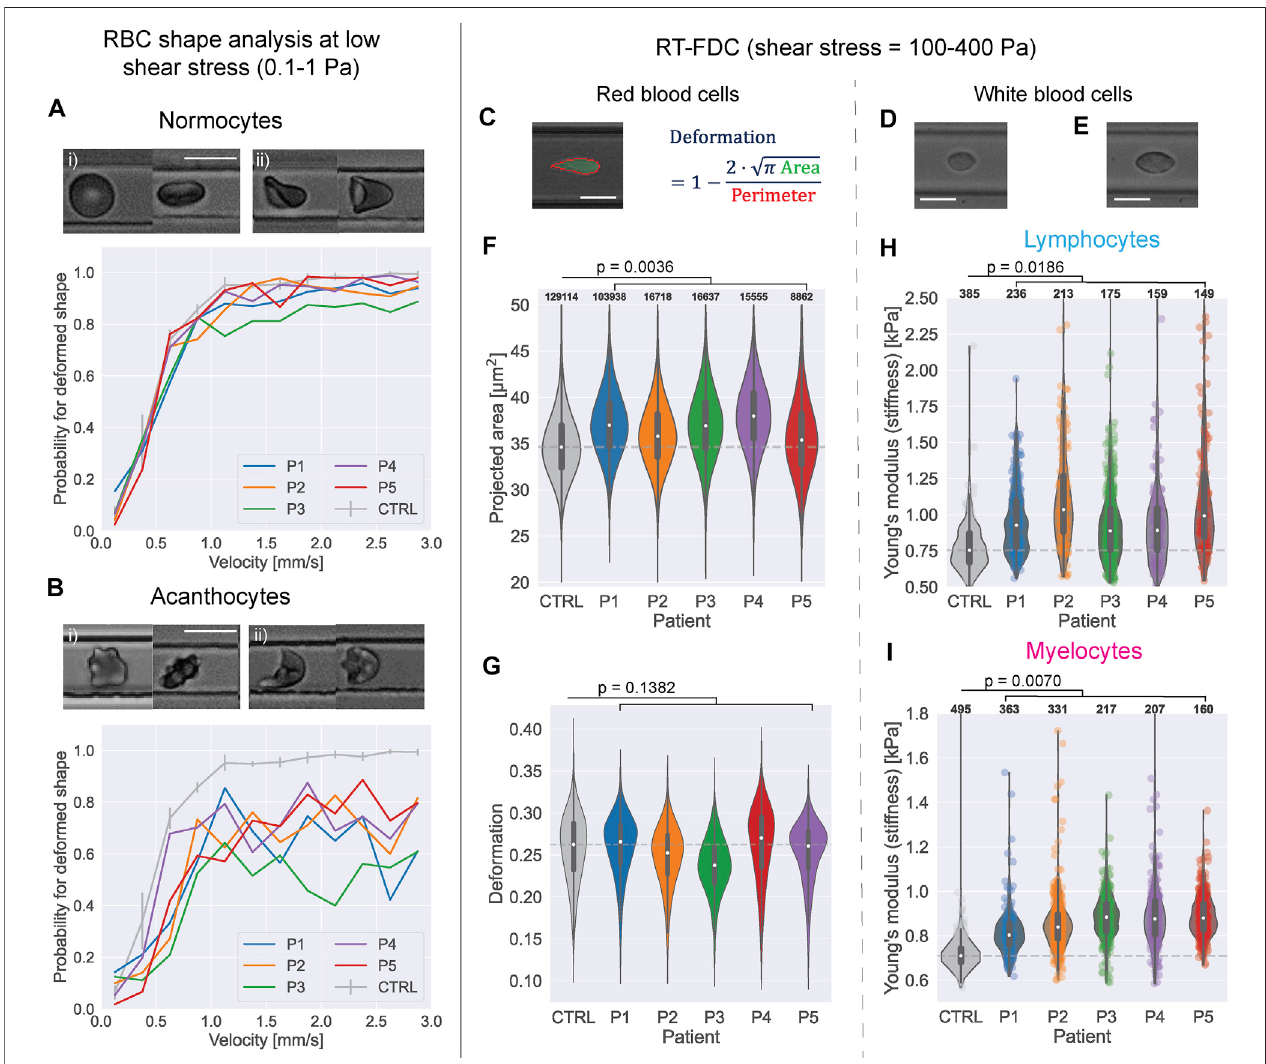
FIGURE 1 | Blood cell deformability of ChAc patients compared to healthy control blood. (A) Example shapes of normal, discocyte RBCs (normocytes) in an (i) undeformedstateand (ii) deformedby fl owduringlowshearstress fl owina10 µmchannel.Thediagramshowstheprobabilityto fi ndnormocytecellsfromthesamplein a deformed state at a given cell velocity in the channel for the acanthocyte patients and the mean curve from three control measurements. Error bars represent SEM. scalebarrepresents10 µm (B) Exampleshapesofacanthocytesinan (i) undeformedstateand (ii) deformedby fl ow.Belowistheshapeprobabilitydiagramforthe acanthocytesandthecontrolcurves. (C) ExampleshapeofanRBCinRT-FDCandrepresentationhowthedeformationparameteriscomputed.Allscalebarsrepresent 10 µm. (D) ExampleimageofalymphocyteinRT-FDC. (E) Exampleimageofamyelocyte. (F)(G) ProjectedareawithinthecontouranddeformationofRBCsoftheChAc patients from RT-FDC measurements vs pooled data from 10 control measurements (full data in Supplementary Figure S4 ). White dots represent the median value; greyboxintheviolinshowsinter-quartilerange(IQR)andextendedlines1.5×IQR.Dashedgreylineshowsthemediancontrolvalue. p -valueswerecalculatedwithlinear- mixed effect models as described in Herbig et al., 2018 (Herbig et al., 2018). Numbers on top of the plots indicate the number of observations per violin. (H) Young ’ s modulus of lymphocytes from ChAc patients vs control (n = 1). (I) Young ’ s modulus of myelocytes from ChAc patients vs control (n = 1).